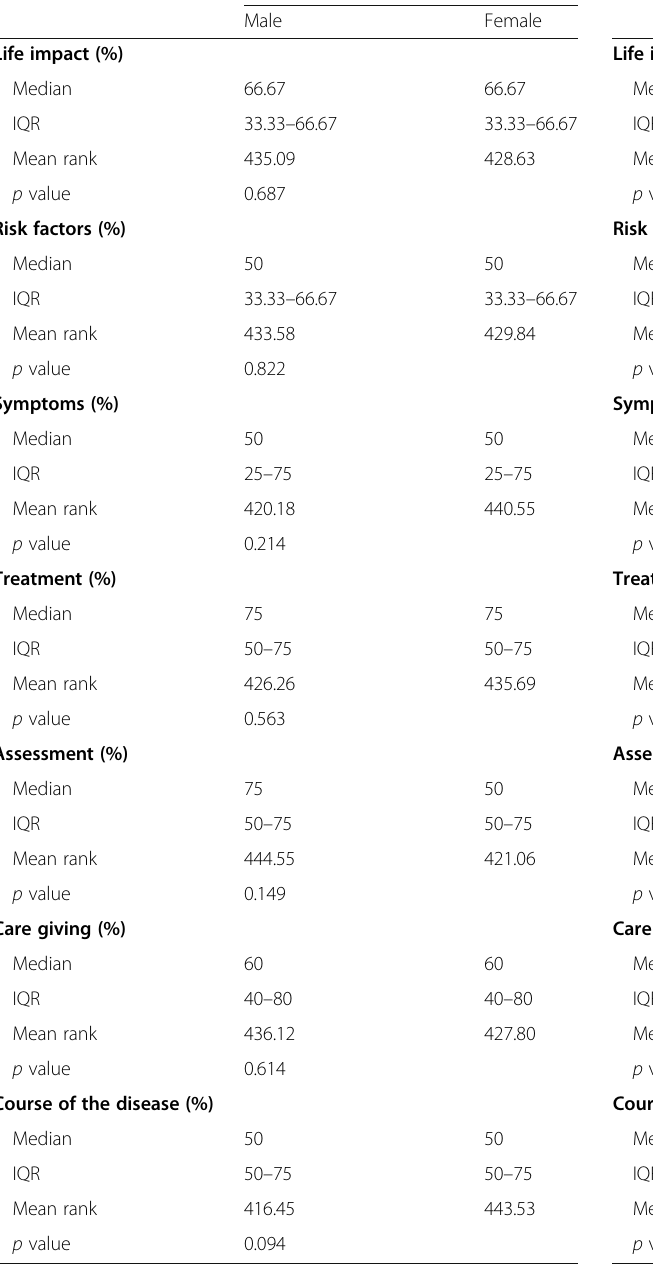
Table 5 Knowledge of different aspects of Alzheimer ’ s disease according to participant ’ s